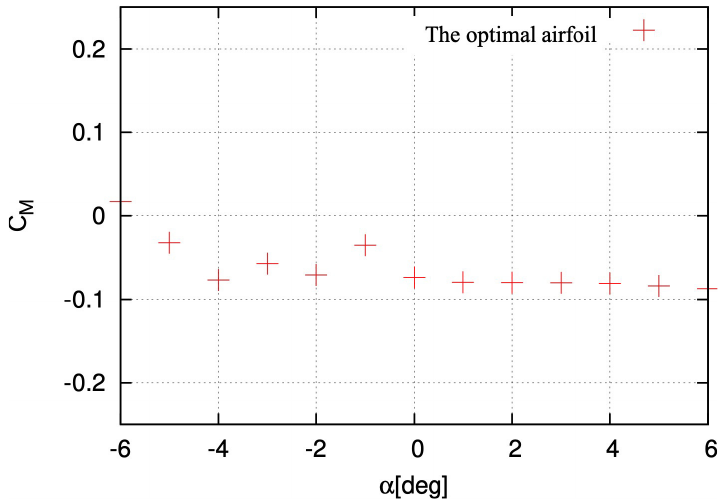
Figure 17. The mean static moment coefficient of the optimal airfoil at Re = 4000 with varying angle of